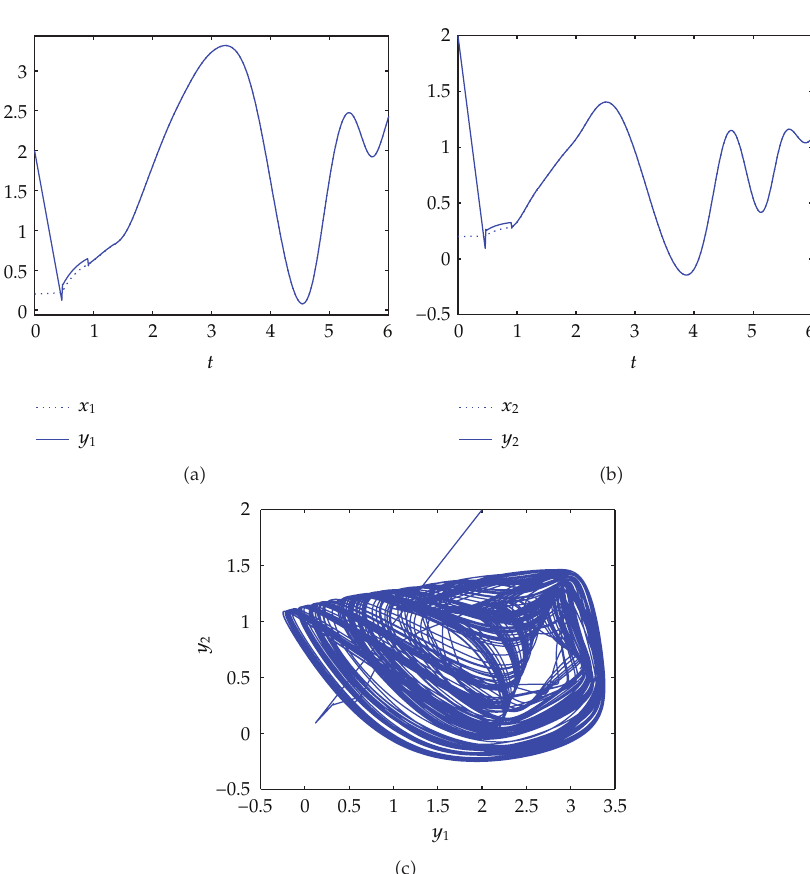
Figure 4: Complete synchronization of the response system (cid:6) 4.5 (cid:7) and the driving system (cid:6) 4.4 (cid:7)